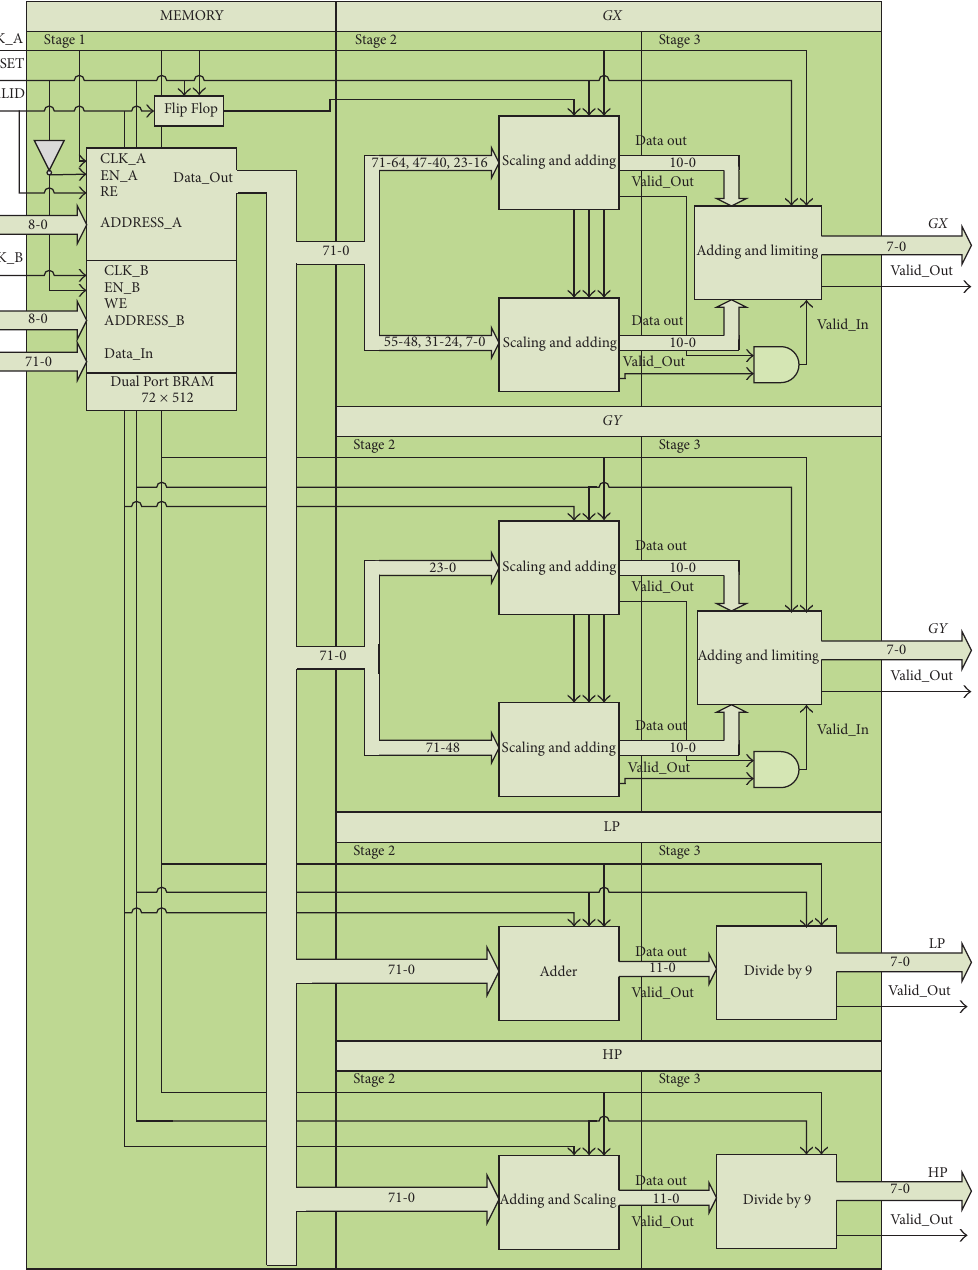
Figure 3: Preprocessing unit functional block